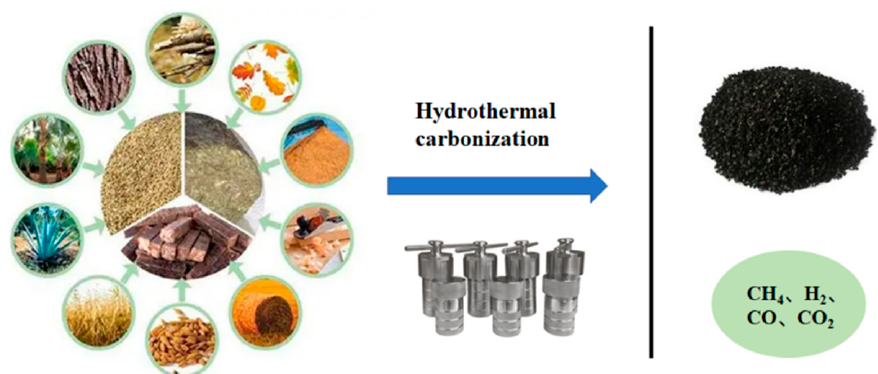
Figure 1. Hydrothermal carbonization of biomass [38].